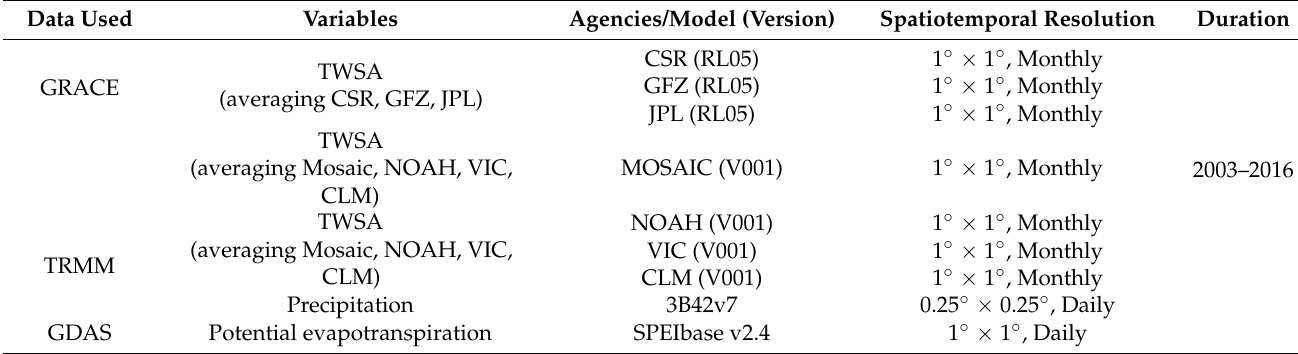
Table 1. Detailed descriptions of each dataset used in this